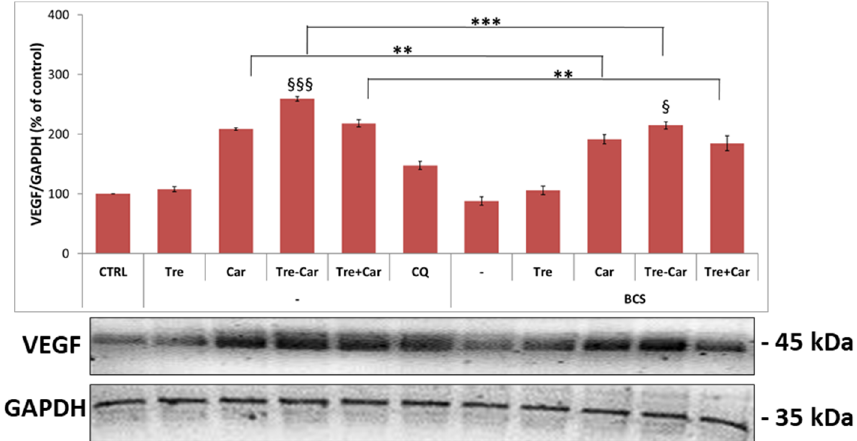
Figure 9. VEGF expression is increased in the presence of Car and Tre-Car. Starved PC12 cells were stimulated by 5mM Tre, Car, Tre-Car and Tre + Car mixture or 10 µ M CQ for 24 h in RPMI-1640 complete medium with 1% of FBS with or without 50 µ M BCS. The expression level of VEGF was reported as ratio over the GAPDH (** p ≤ 0.01, *** p ≤ 0.001 versus the respective treatment; § p ≤ 0.05 and §§§ p ≤ 0.001 versus respective carnosine treatment). Dashes to the right of the membrane bands show positions of prestained molecular mass